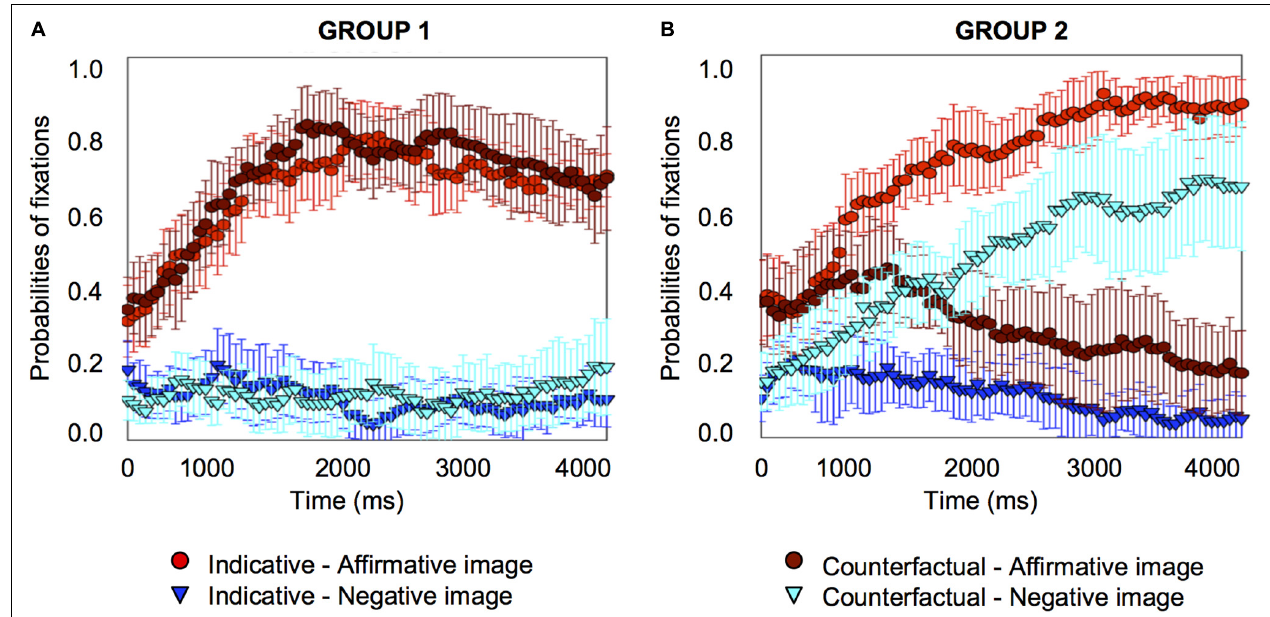
FIGURE 6 | Individual differences probabilities of fixations for indicative and counterfactual sentences for a subset group of 10 participants who looked at the affirmative image for counterfactuals (A) , and a subset group of eight participants who looked at the negative image only or at the affirmative and negative image for counterfactuals (B) in Experiment 2. Error bars are 95% confidence intervals within